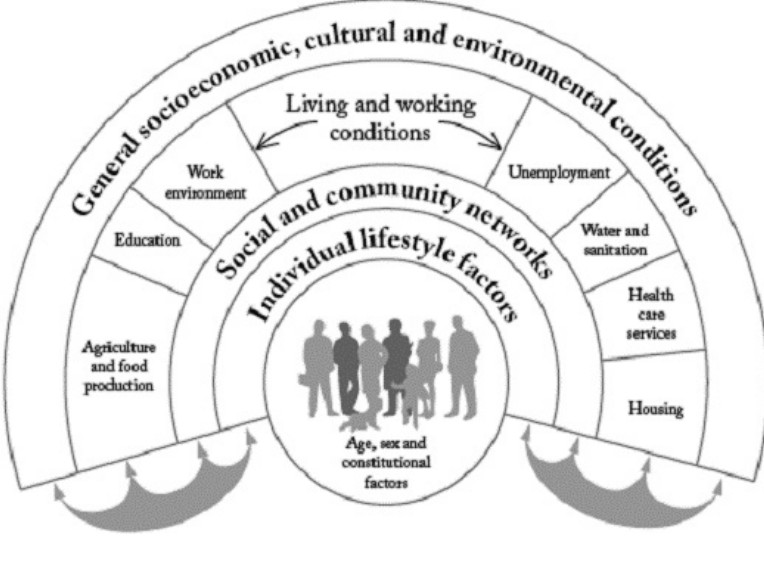
FIGURE 1. THE BROAD DETERMINANTS OF HEALTH Dahlgren, G. and Whitehead, M. (1991). Policies and Strategies to Promote Social Equity in Health. Stockholm, Sweden: Institute for Futures Studies. Used with